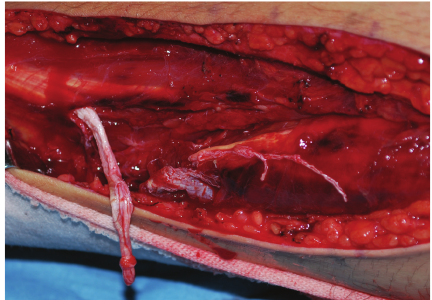
Figure2:Intraoperativephotographofleftleg.Distalbicepsfemoris tendon is completely ruptured at musculotendinous junction.